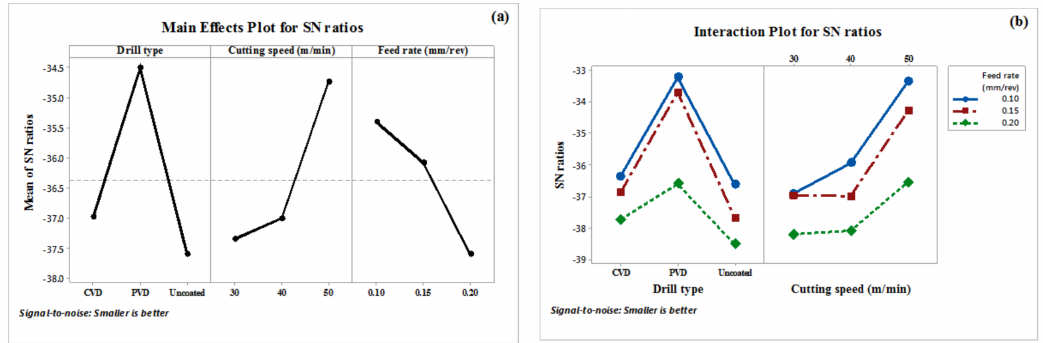
Figure 8. ( a ) Plot of main effects for S/N ratio; and ( b ) interaction plot for S/N ratios; of thrust force for (Mg/SiC/GNPs) hybrid MMC.